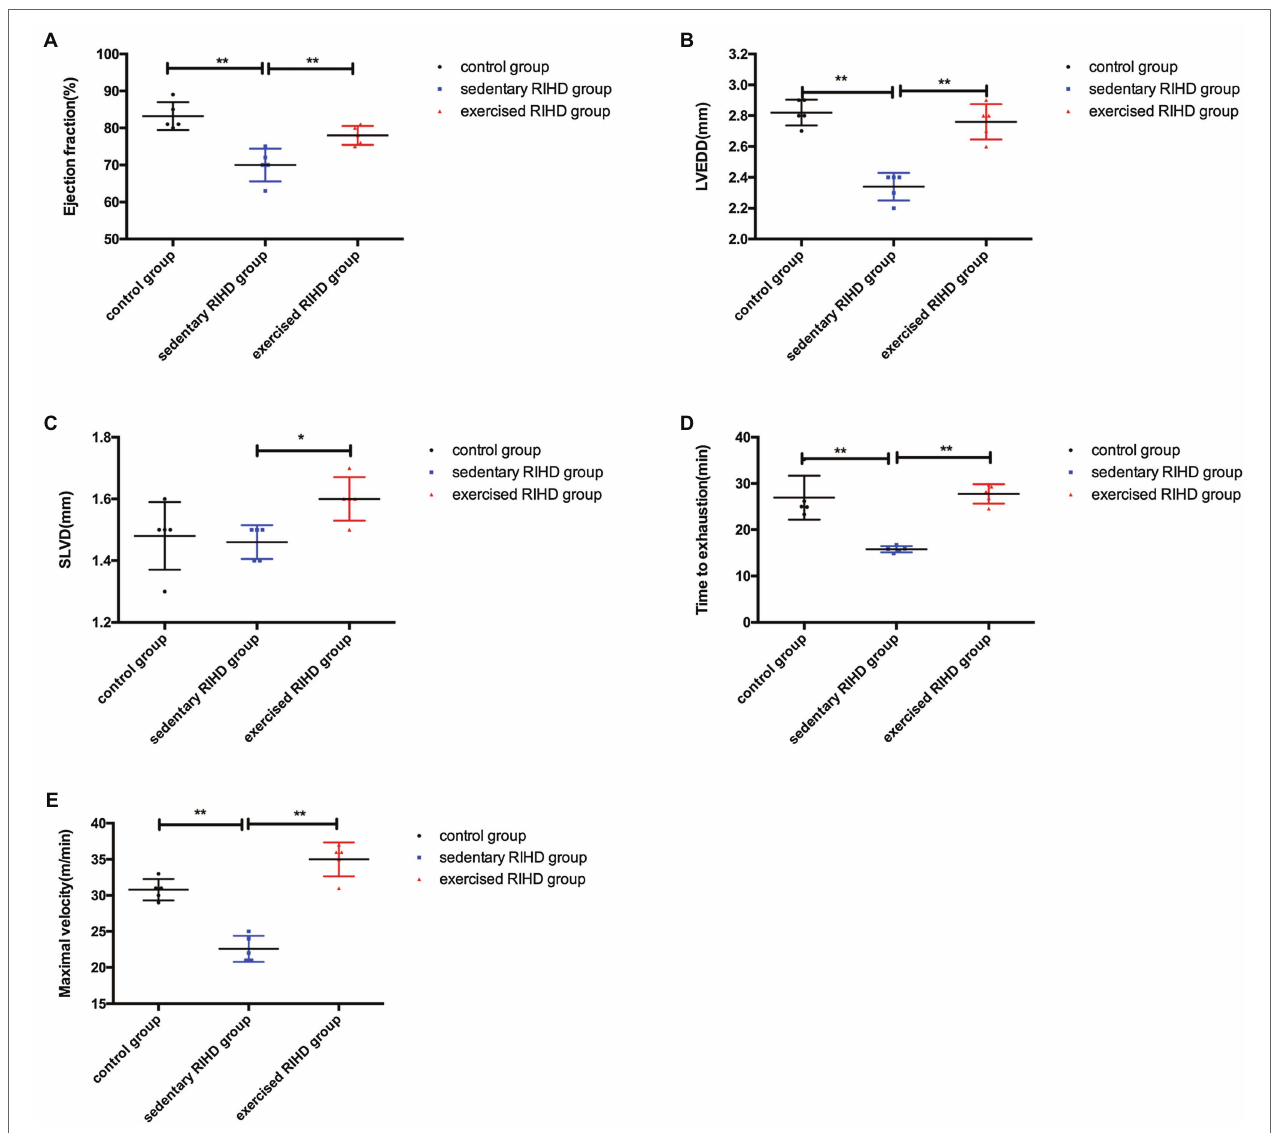
FIGURE 2 | The effect of exercise on cardiac function and aerobic fitness in RIHD mice. Values for EF (A) and LVEDD (B) among groups were compared by ANOVA. (C) The Mann–Whitney U test was used to compare the SLVD among groups. (D) Time to exhaustion among the groups was compared by ANOVA. (E) Maximal velocity among the three groups was compared by ANOVA. n = 5 samples/group. * p < 0.05, ** p < 0.01. LVEDD, lower left ventricular end-diastolic dimension; SLVD, systolic left ventricular dimension; EF, ejection